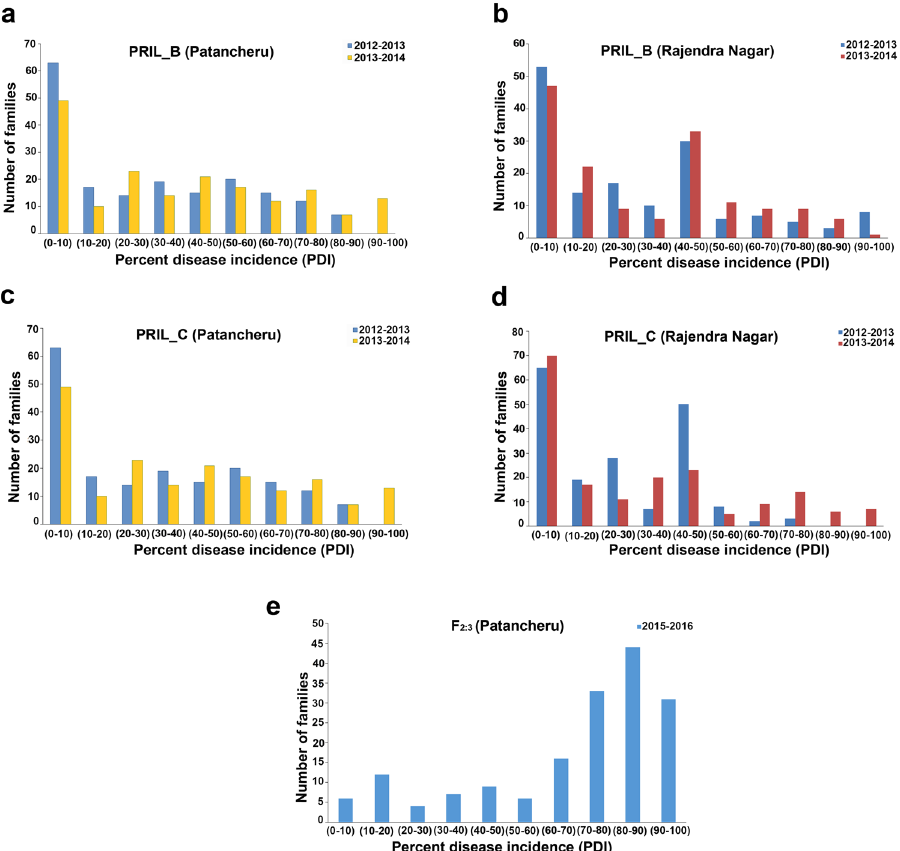
Figure 1. Frequency distribution of percent disease incidence (PDI) for Patancheru SMD isolate in various populations at different locations and years. The disease scoring was done on the basis of percentage of affected plants wherein 0% means complete resistance while 100% means complete susceptibility to SMD. The PDI was monitored for two consecutive years (2012–2013, 2013–2014) in ICPL 20096 × ICPL 332 (PRIL_B) and ICPL 20097 × ICP 8863 (PRIL_C) population while for one year (2015–2016) in ICP 8863 × ICPL 87119 (F 2 ) population. The PDI was divided into 10 categories and number of families falling in each category were plotted as bar plot. The PDI in ICPL 20096 × ICPL 332 (PRIL_B) population at Patancheru location and Rajendranagar, Hyderabad location is shown in a and b . Figure c and d represent PDI in ICPL 20097 × ICP 8863 (PRIL_C) population at Patancheru and Rajendranagar, Hyderabad location respectively, while, the Figure e represents the PDI in ICP 8863 × ICPL 87119 (F 2 ) population at Patancheru